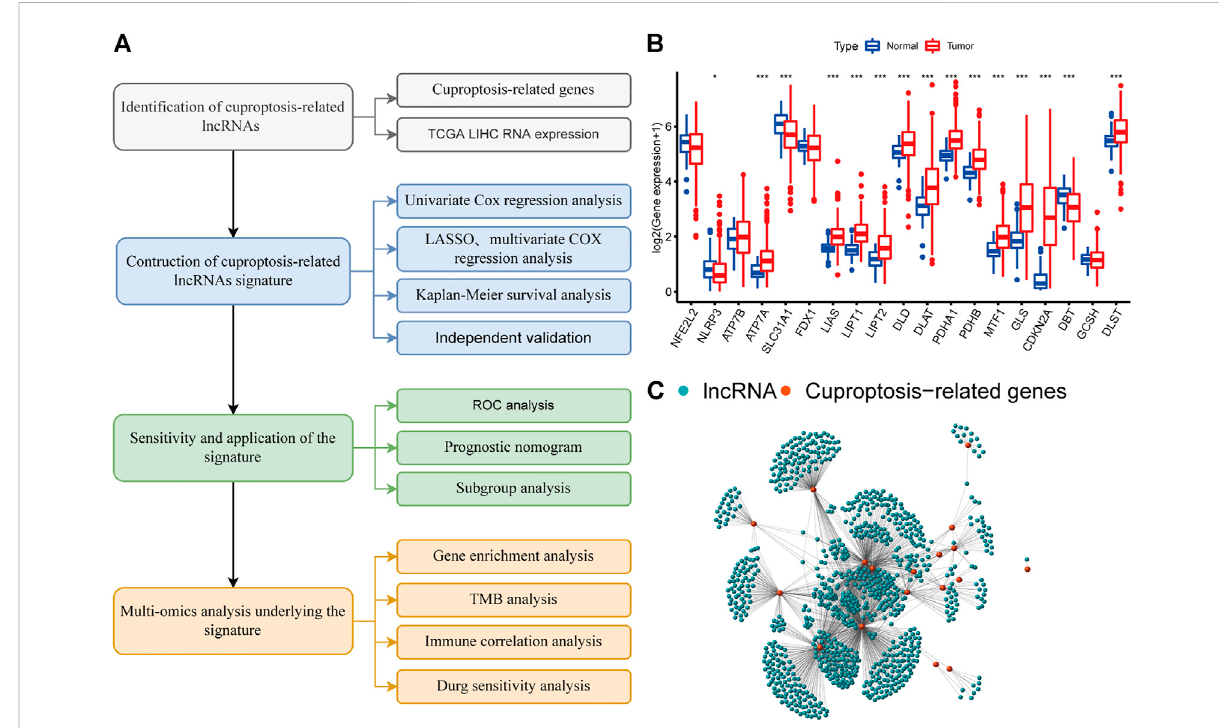
FIGURE 1 A screen of the differentially expressed cuproptosis-associated lncRNAs in hepatocellular carcinoma (HCC) (A) Flowchart of the present research. (B) Differential expression of cuproptosis-related genes in normal and HCC tissue (C) Network graph of cuproptosis-associated